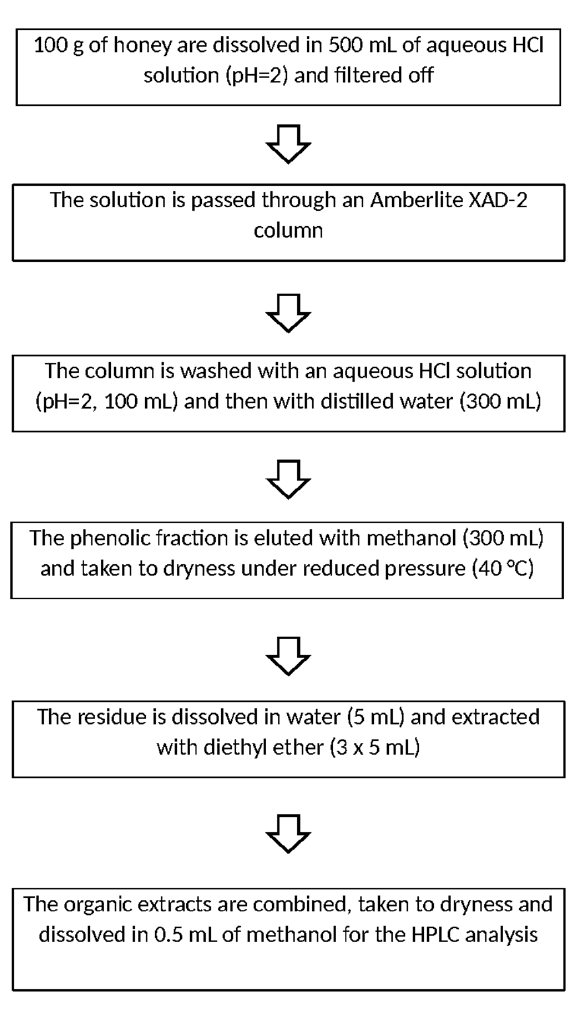
Figure 4. Extraction/clean-up of polyphenols from unifloral honey on Amberlite XAD-2, according [49].